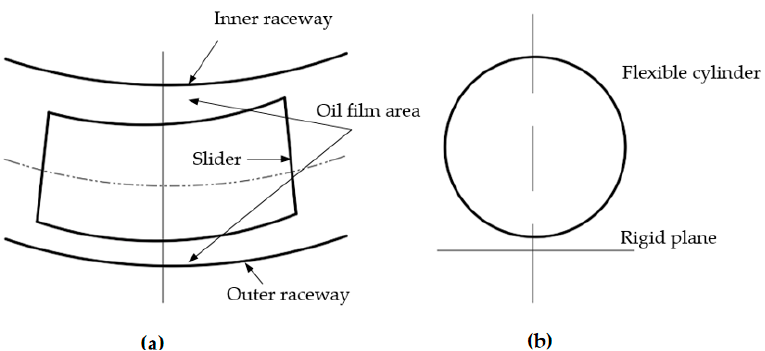
Figure 16. Lubrication structure of slider, ( a ) Lubrication area; ( b ) Cylinder contact with rigid. (Adapted from [167]).